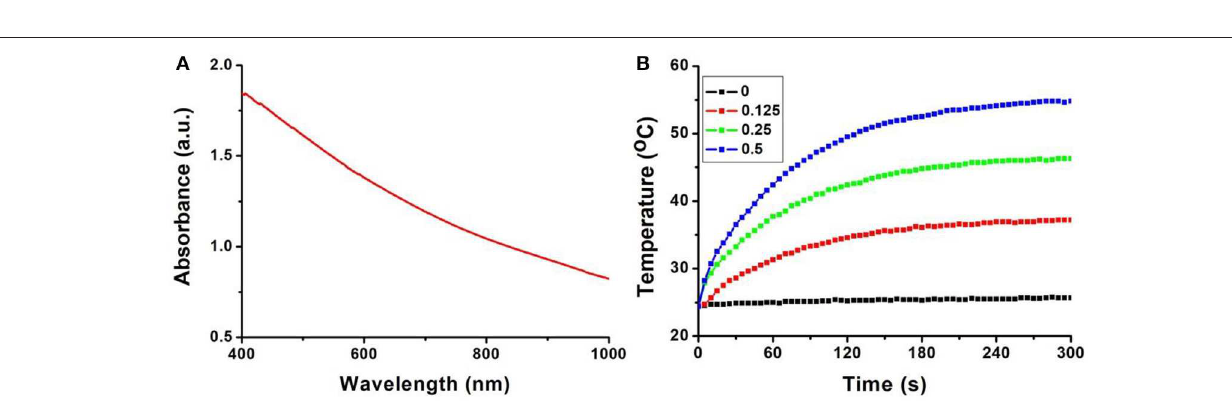
FIGURE 2 | (A) Temperature change of the Fe 3 S 4 nanoparticles in water at varied concentrations of Fe 2 + (i.e., 0, 0.5, and 1.0 mg/mL) as a function of magnetic field action time. (B) Plot of temperature change over 300s vs. the concentration of Fe 3 S 4 nanoparticles. Thermal imaging of (C) pure water and (D) Fe 3 S 4 nanoparticles (1.0 mg/mL) under the action of an AMF for 5min.